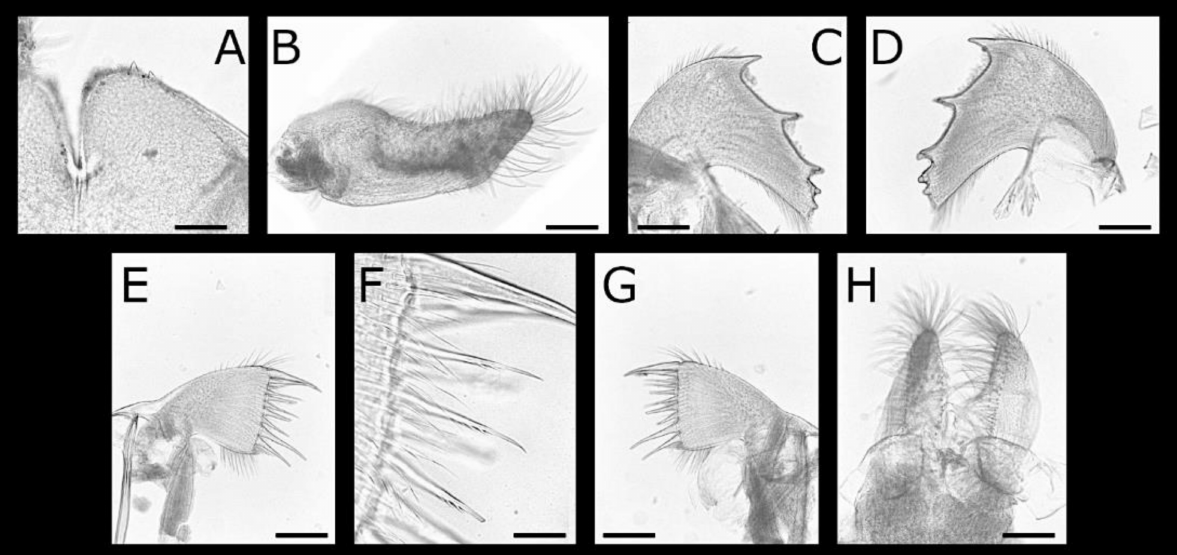
Figure 26. Pectinoacasta sculpturata (Broch, 1931) mouthparts (WAM C61395). ( A ) crest of labrum; ( B ) right mandibular palp; ( C , D ) left and right mandibles; ( E ) left maxillule; ( F ) serrated setae on left maxillule; ( G ) right maxillule; ( H ) left and right maxillae. Scale bars: A = 100 µ m; B–F, H = 200 µ m; G = 50 µ m.